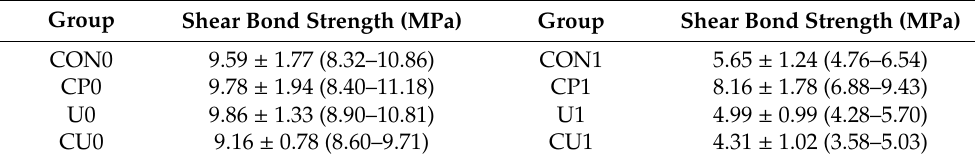
Table 3. Comparison of shear bond strength (mean ± SD (range)) of all groups.